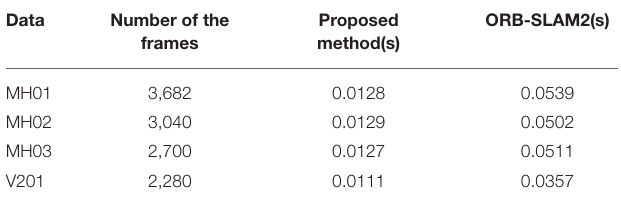
TABLE 1 | The processing time per